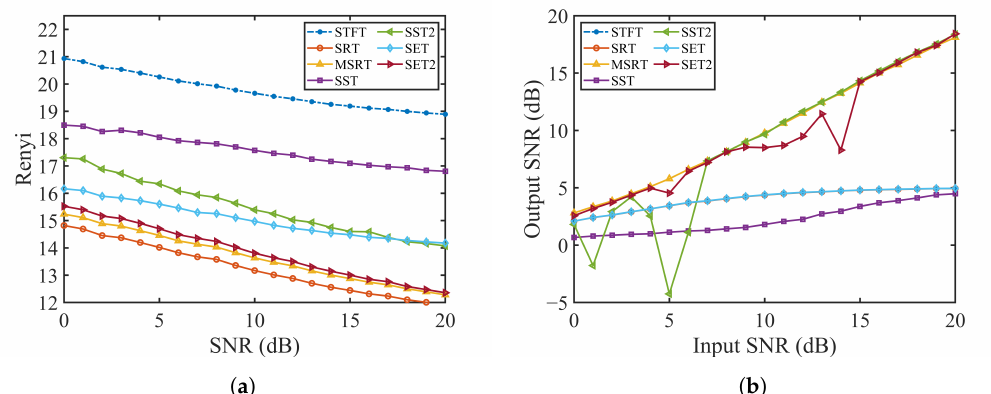
Figure 9. Noise robustness verification results of the MSRT. ( a ) Rényi entropy under different SNR conditions. ( b ) Output SNR of reconstruction results under different SNR